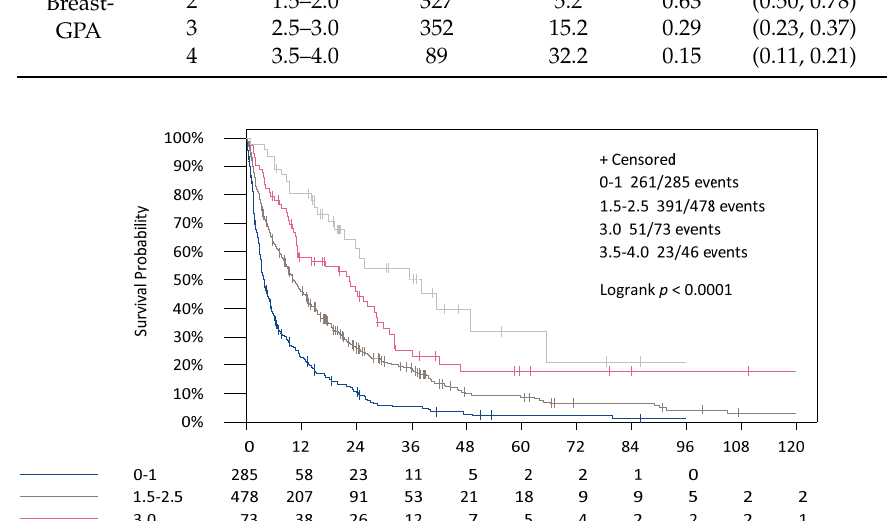
Logrank p < 0.0001